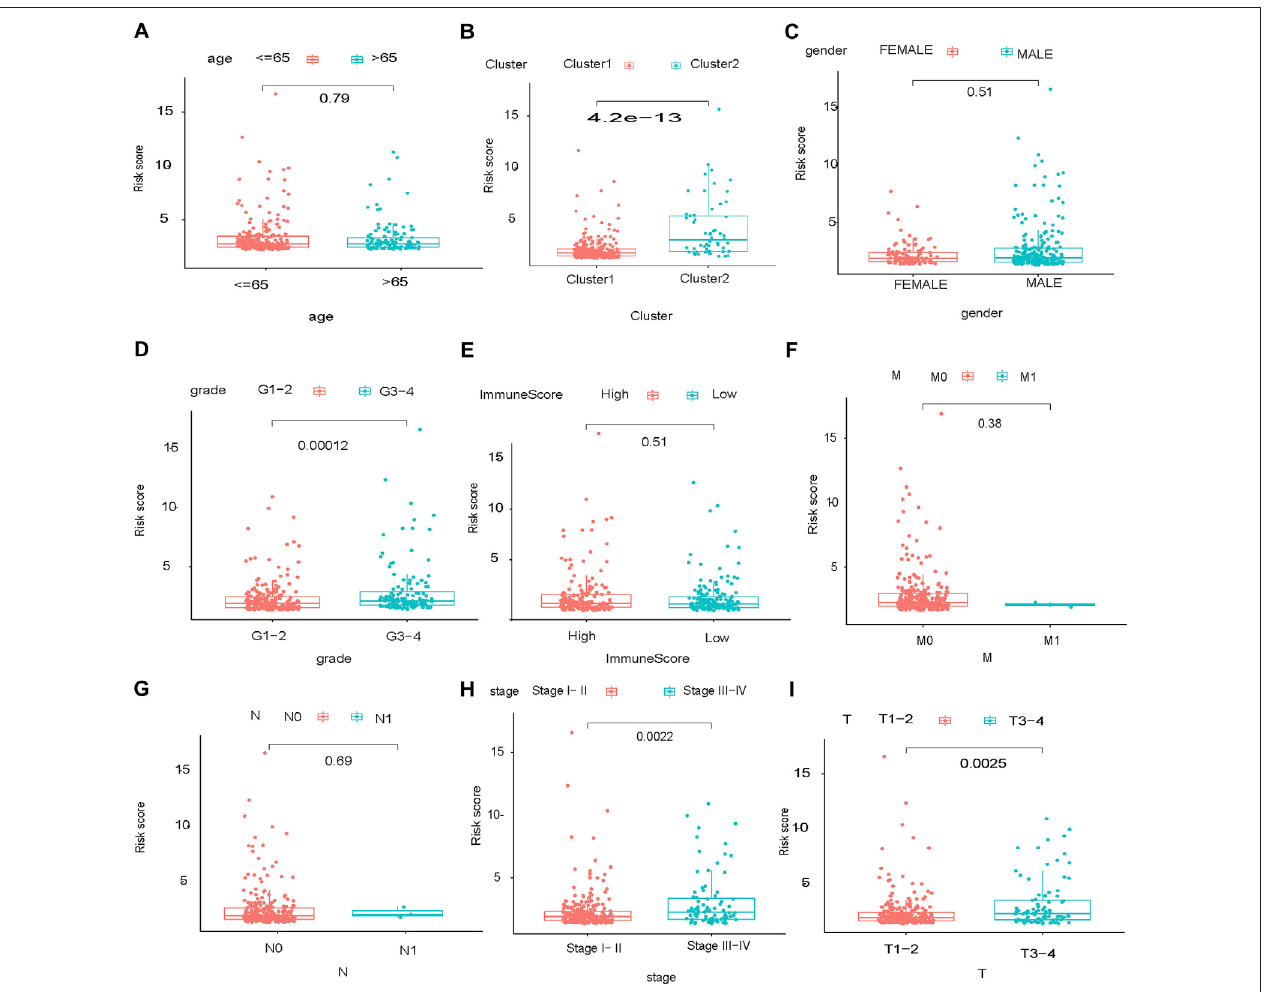
FIGURE 7 | Strati fi cation of the prognostic glycolysis-related gene signature. Stage of HCC: TMN, high:high risk, low:low risk.